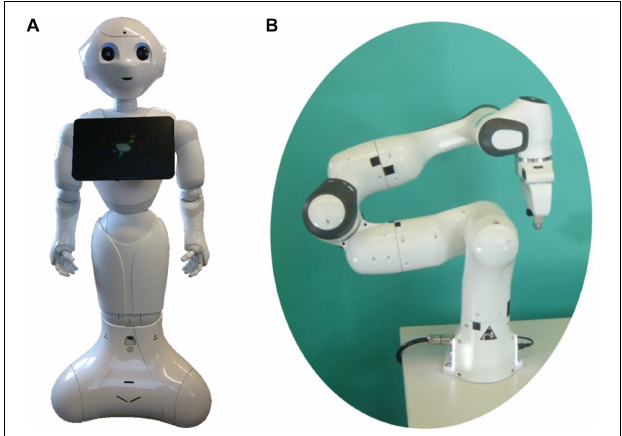
FIGURE 1 | (A) On the left the robot “ Pepper ” from Aldebaran Robotics SAS and SoftBank Mobile Corp and (B) On the right the robot “ Panda ” from FRANKA EMIKA. The photos of the robots were taken and edited by Alexandra